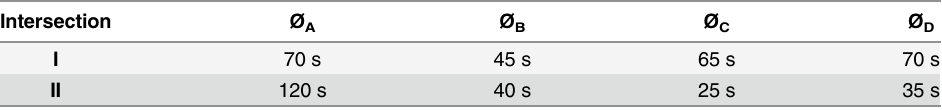
Table 1. Green time period for Intersection I and